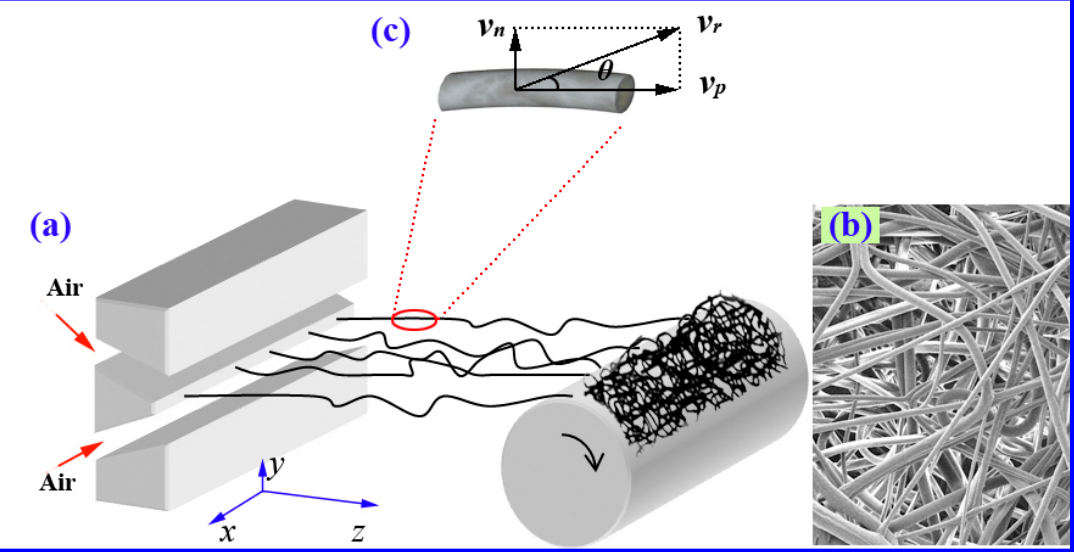
Figure 1. ( a ) Schematic of commercial slot-die melt-blown process. ( b ) The microfibrous nonwovens produced by melt blowing. ( c ) Schematic of a fiber fragment near the die and the air velocity applied on it.